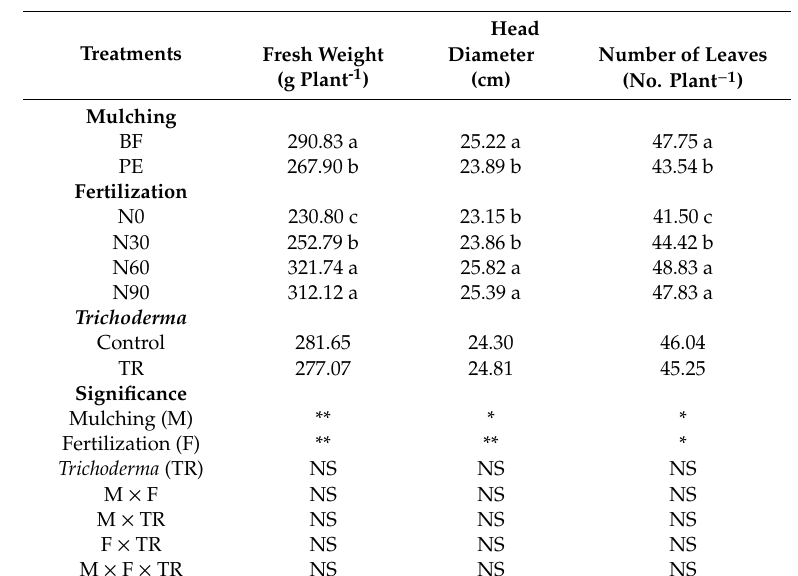
Table 1. Lettuce growth parameters in relation to mulching cover films (brown photoselective film —YF and a black polyethylene—PE), Trichoderma application (untreated—Control and treated—TR) and N fertilization rates (N0 = 0, N30 = 30, N60 = 60, and N90 = 90 kg ha − 1